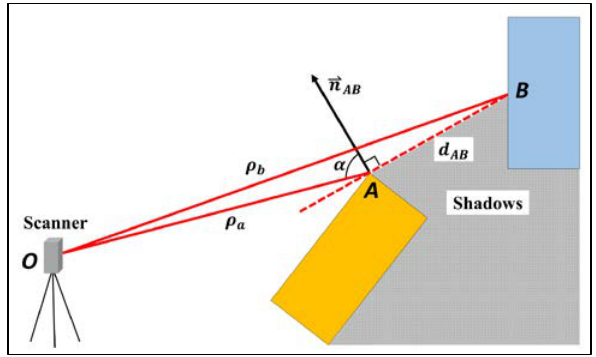
Figure 1. Silhouette edge detection based on projected incidence angle: A is the current point being analyzed, lying on